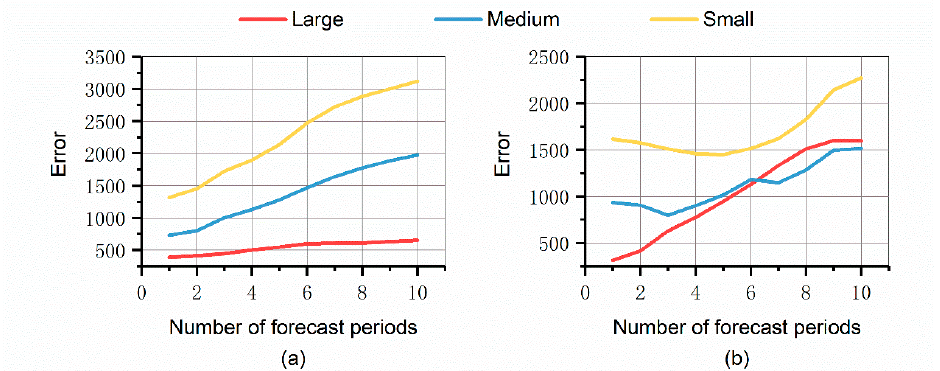
Figure 8. Curves of SARIMA prediction error with lag periods variation. ( a ) indicates the market capacity forecast error on the test set with lag periods variation; ( b ) indicates the market capacity forecast error on the forecast set with lag periods variation.